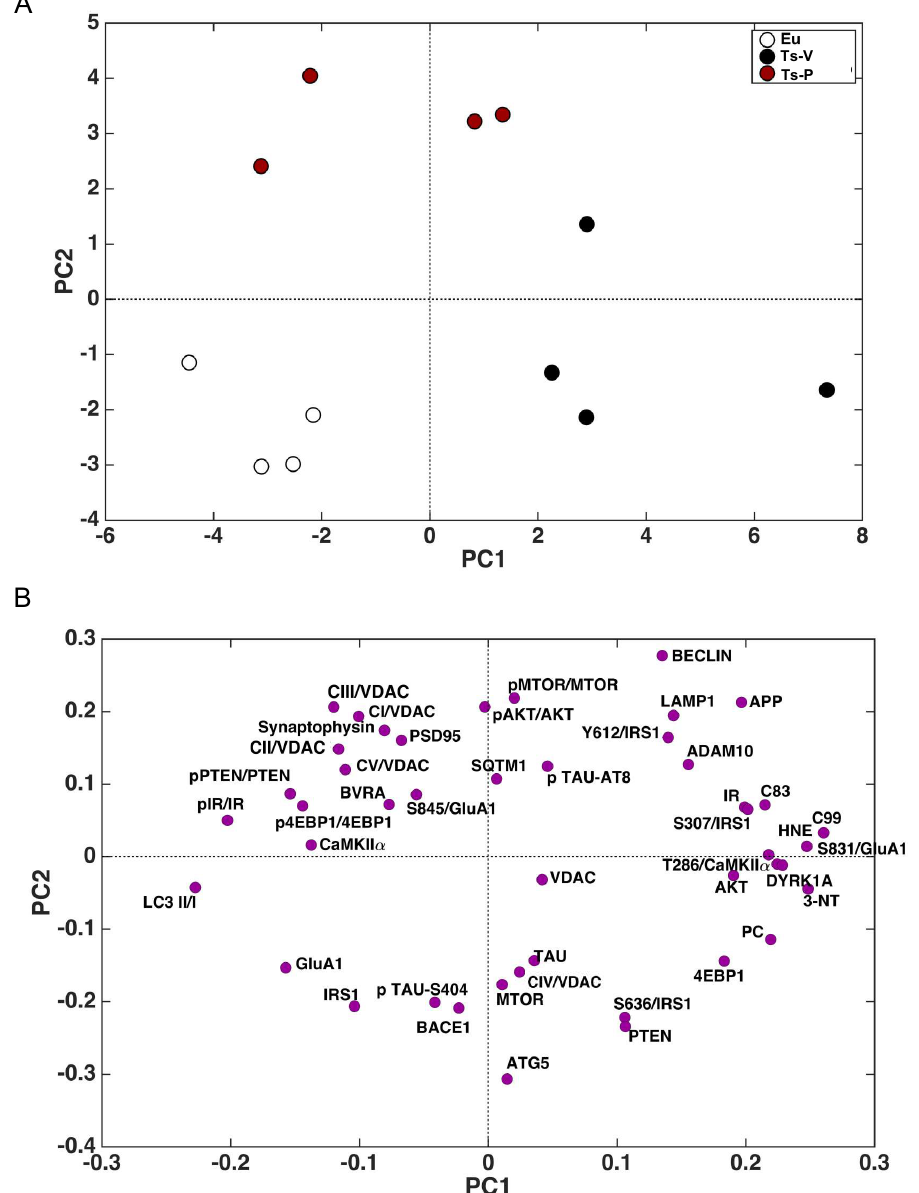
Figure 7. Principal component analysis results. Principal component analysis (PCA) was performed on the results collected in mice to determine variance contribution of the components associated with the observed neuroprotective effects promoted by KYCCSRK administration in Ts-P mice. Score plots ( A ) and loadings ( B ) graphs are shown.